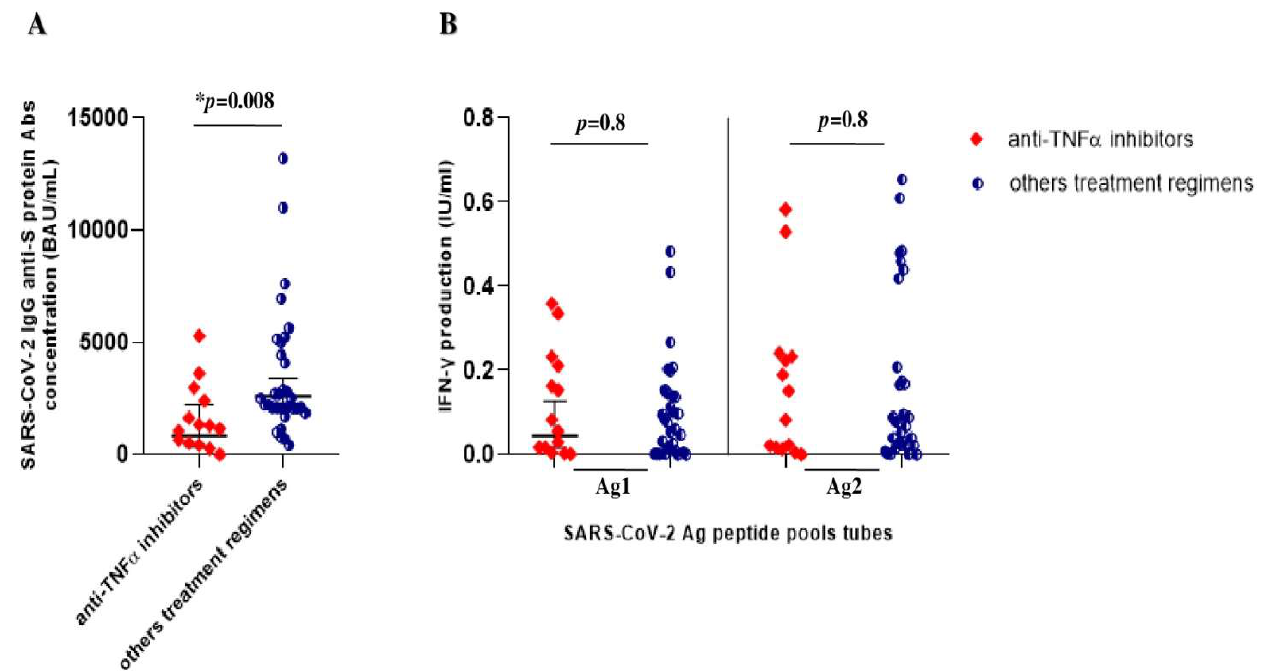
Figure 3. SARS-CoV-2 vaccine-elicited immune response after booster shot in IBD patients onanti- TNFα treatment and other treatment regimens. ( A ) Anti-SARS-CoV-2 trimeric S protein antibody concentration (BAU/mL) in IBD patients on anti-TNFα treatments (red rhombs) vs. other treatment regimens (aminosalicylates and vedolizumab) (blue circles). ( B ) QuantiFERON SARS-CoV-2 antigen tube (Ag1 and Ag2) responses, express as IFN- γ production (IU/mL), in IBD patients on anti-TNF α treatments (red rhombs) vs. other regimens (aminosalicylates and vedolizumab) (blue circles). Legend: the * highlight the significance of p -value < 0.05.